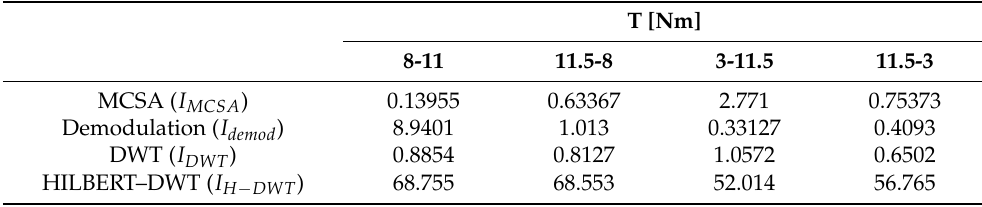
Figure 9. Value of the proposed diagnostic index I H − DWT in transient conditions as a function of the requested torque ramp, with f = 50 Hz. The stars state the simulated points, the blue line is the linear interpolation. Table 4. Diagnostic indexes at variable speed—linear ramp in requested